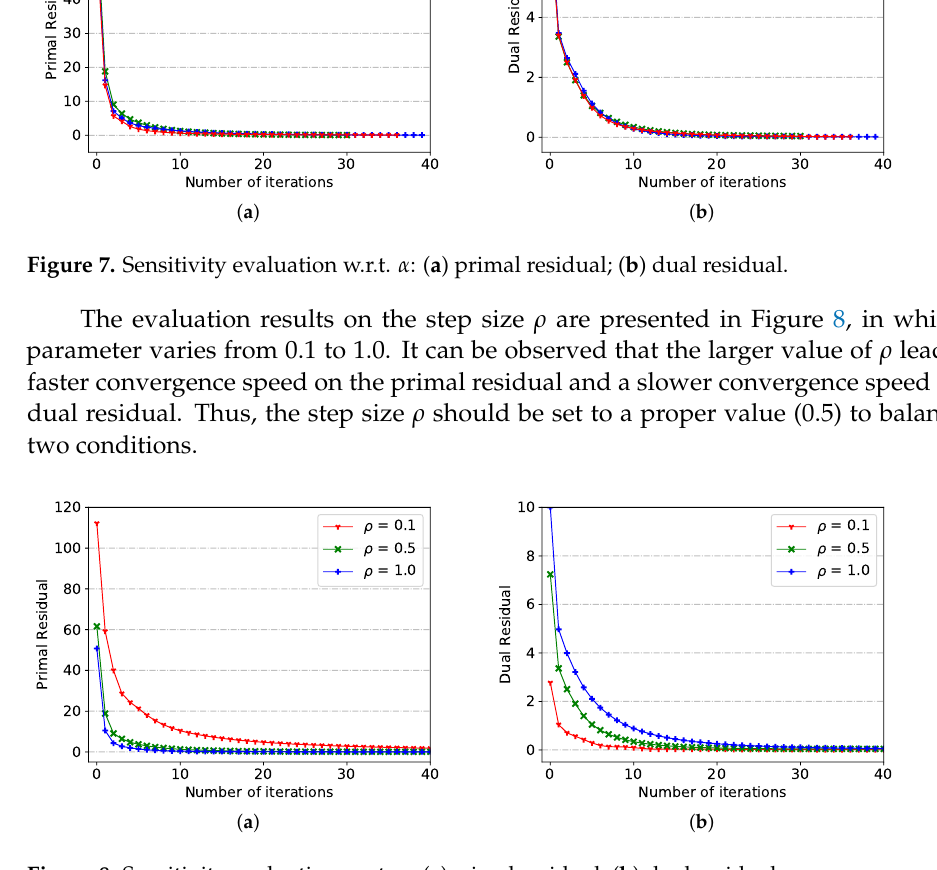
Figure 8. Sensitivity evaluation w.r.t. ρ : ( a )primal residual; ( b ) dual